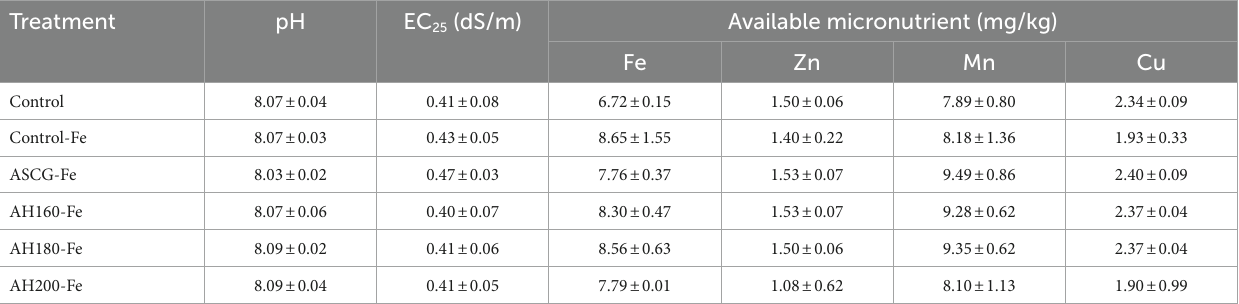
TABLE 2 Effects on soil properties of the activated bio-chelates after 40 days of cultivation.